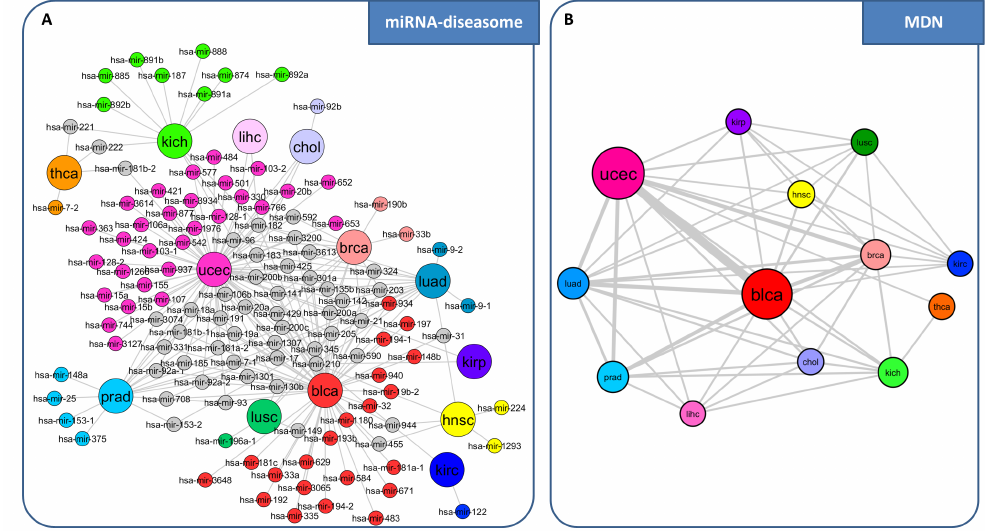
Figure 7. Comparative analysis of miRNAs acting as switch genes in the large panel of